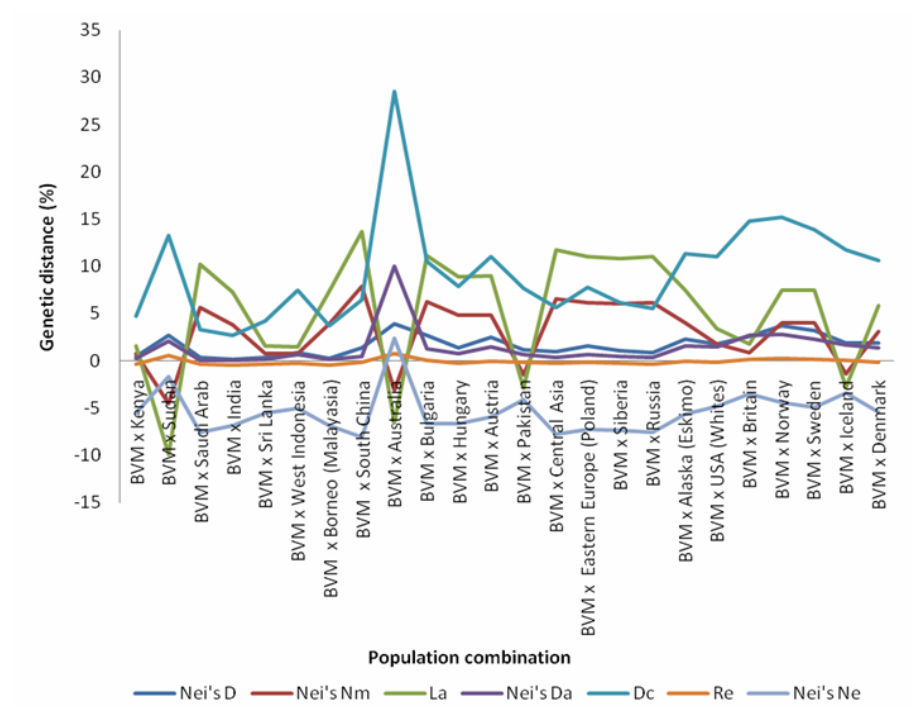
Fig. 1. Comparison of different genetic distance measures between BVM and other